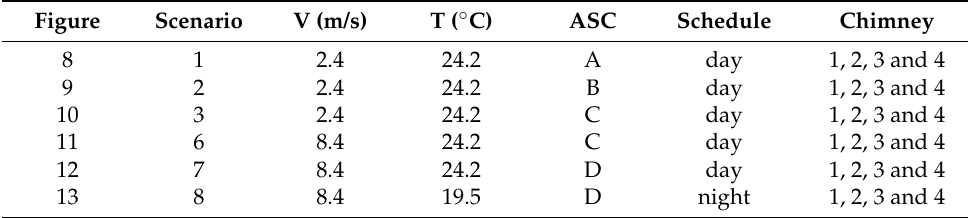
Table 7. Scenarios and conditions of the modeling variables according to ASC. Figure Scenario ASC Schedule